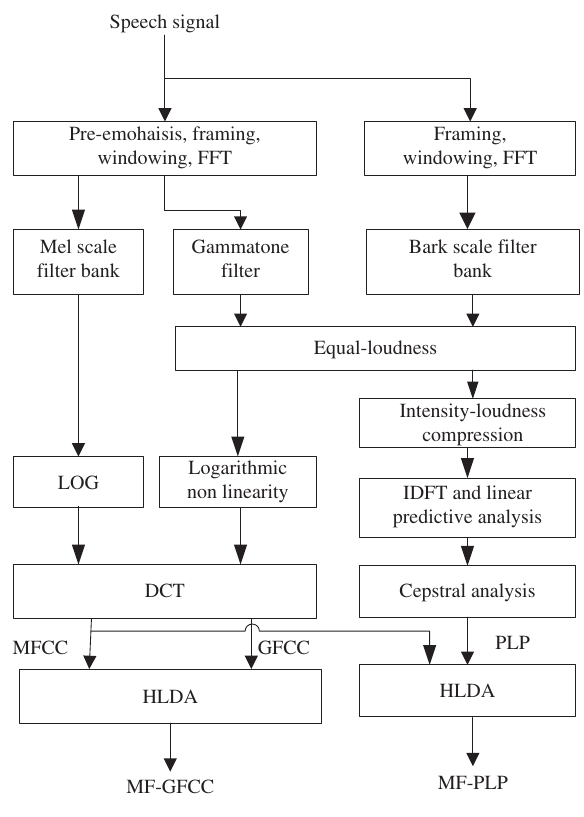
Figure 1: Proposed Feature Vector